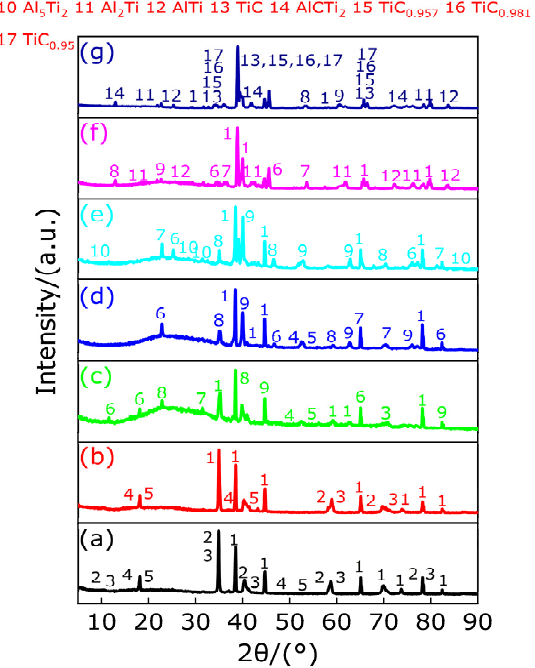
Figure 21. XRD patterns of the residue of the sample (Al-rich Al/PTFE/TiH 2 composite) at different peak temperatures and 1000 ◦ C. ( a ) XRD pattern at 339.4 ◦ C; ( b ) XRD pattern at 370.1 ◦ C; ( c ) XRD pattern at 523.7 ◦ C; ( d ) XRD pattern at 553.6 ◦ C; ( e ) XRD pattern at 594.5 ◦ C; ( f ) XRD pattern at 942 ◦ C; ( g ) XRD pattern at 1000 ◦